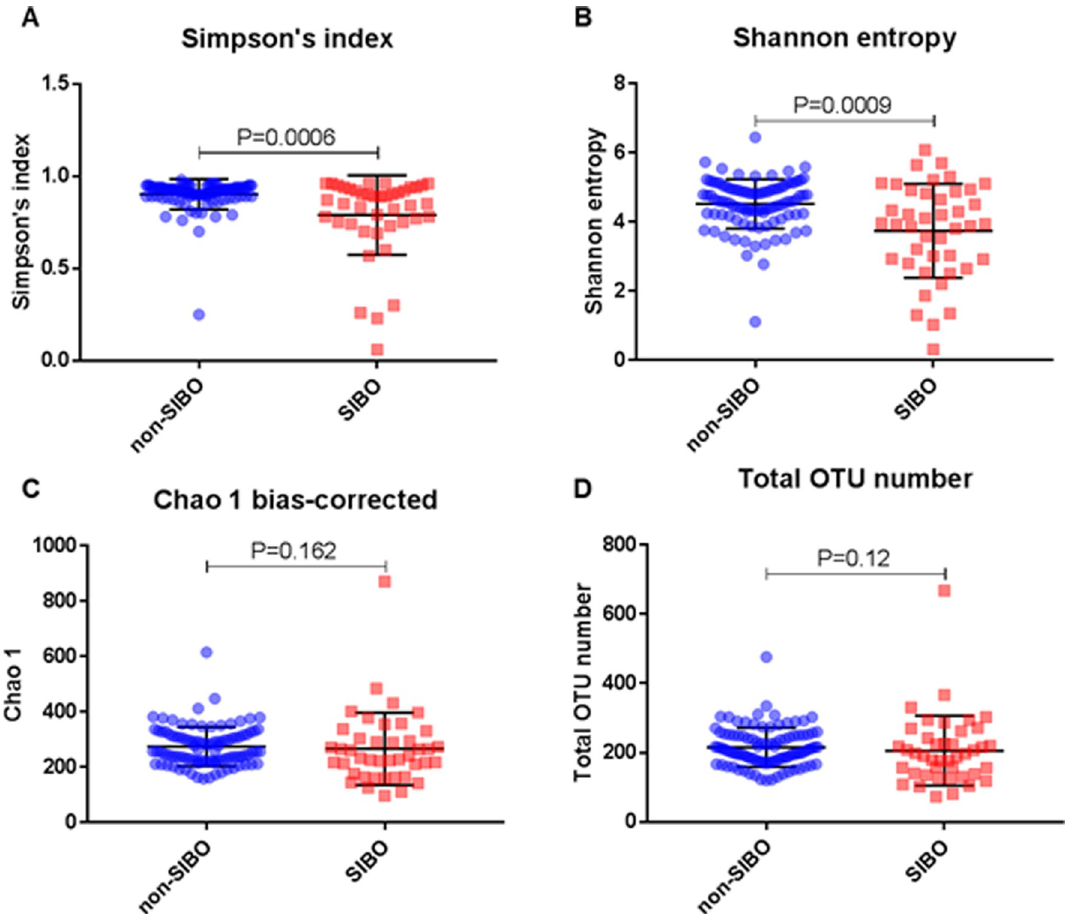
Fig 1. Alpha diversity of SIBO (N = 42) and non-SIBO (N = 198) subjects, as identified by microbial counts on MacConkey agar. A—Simpson’s index diversity; B—Shannon entropy diversity; C–Chao 1 diversity; D–Total number diversity.